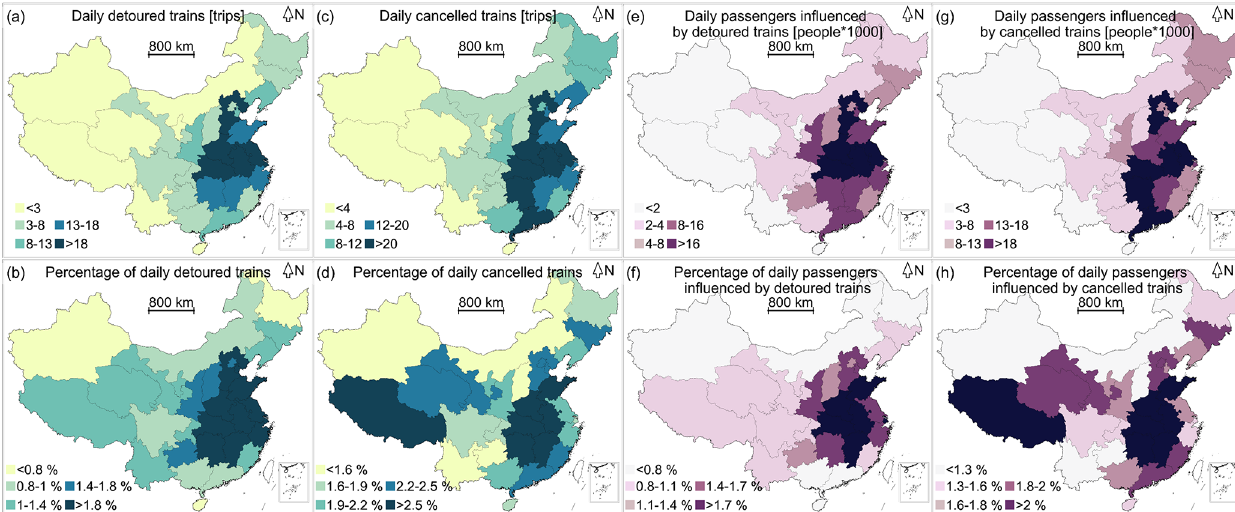
Figure A4. Performance loss of the railway system per province. Panel (a) presents the daily detoured trains in absolute terms; (b) presents the daily detoured trains relative to the number of the province’s daily trains; (c) presents the daily cancelled trains in absolute terms; (d) presents the daily cancelled trains relative to the number of the province’s daily trains; (e) presents the daily passengers influenced by detoured trains in absolute terms; (f) presents the daily passengers influenced by detoured trains relative to the number of the province’s daily trains; (g) presents the daily passengers influenced by cancelled trains in absolute terms; (h) presents the daily passengers influenced by cancelled trains relative to the number of the province’s daily trains.